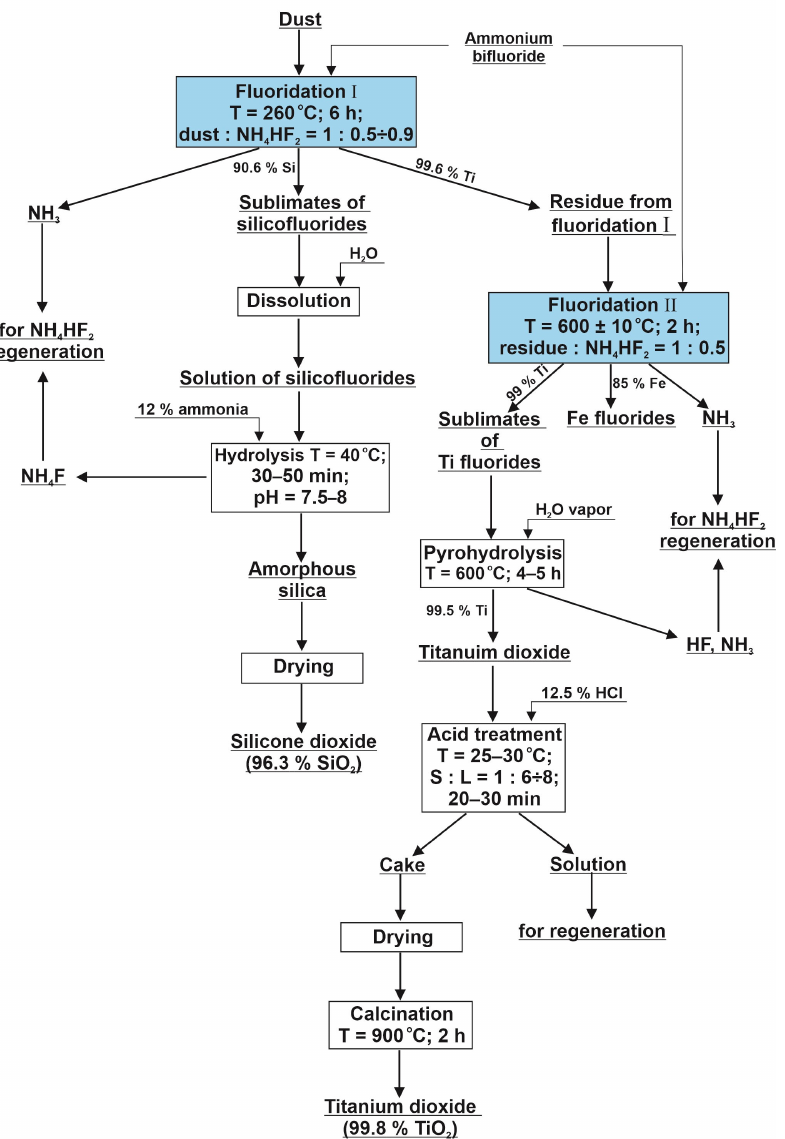
Figure 9. Basic process flow of fine dust processing of electric smelting of ilmenite concentrates.